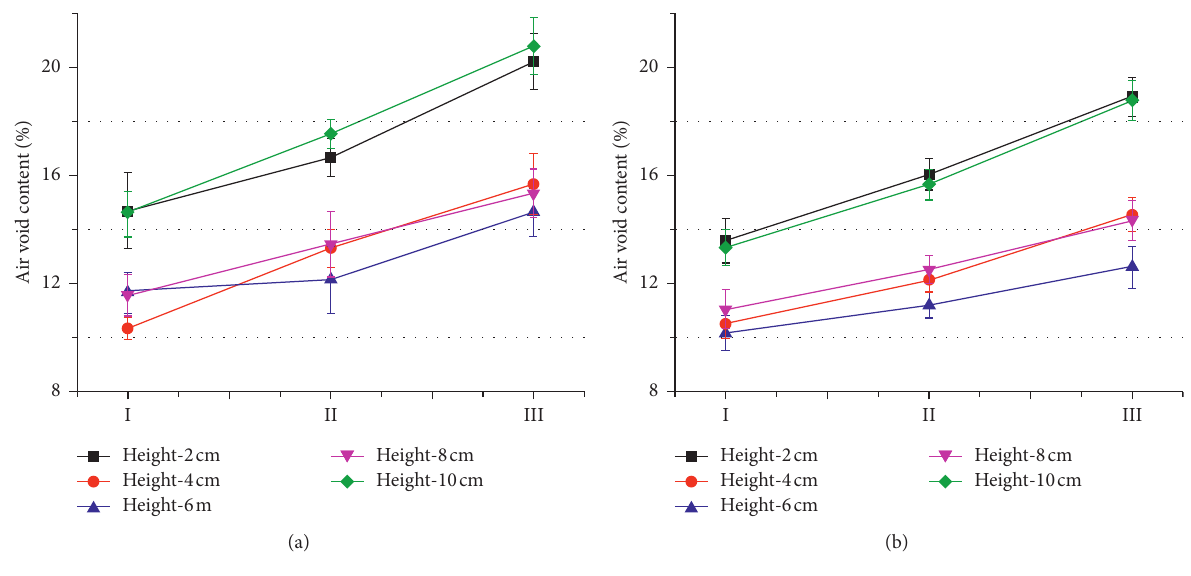
Figure 7: Air void distribution in horizontal direction. (a) G1. (b) G2.